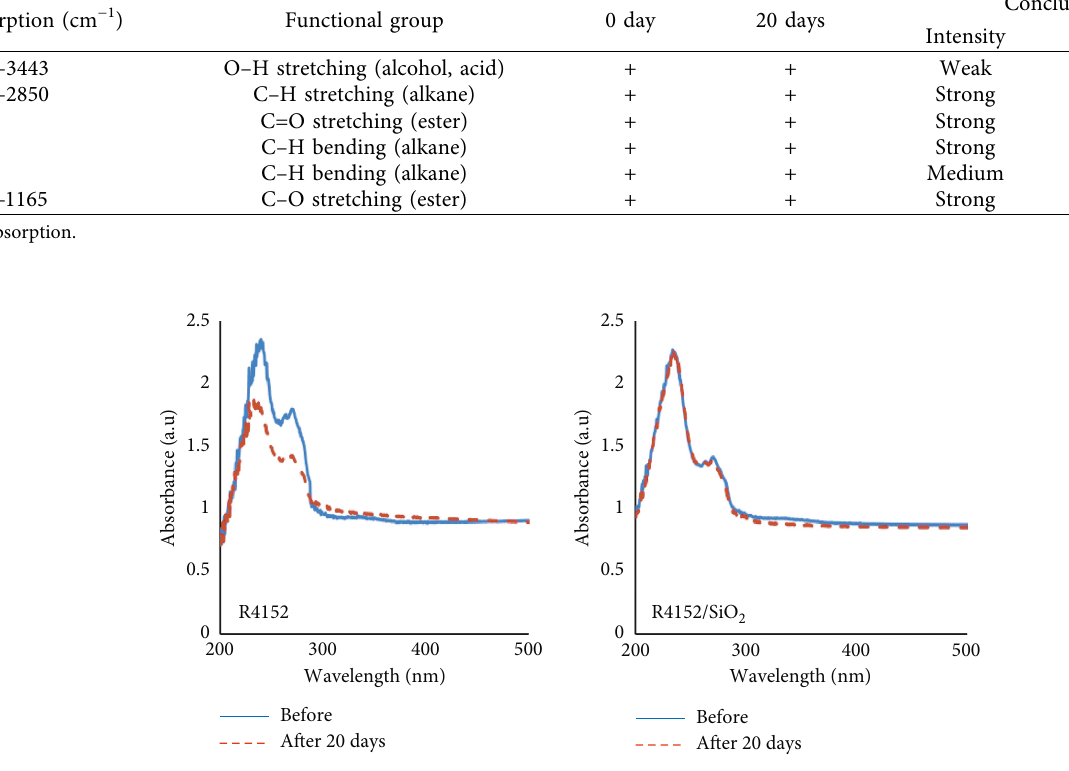
2 before and after immersion in the saturated